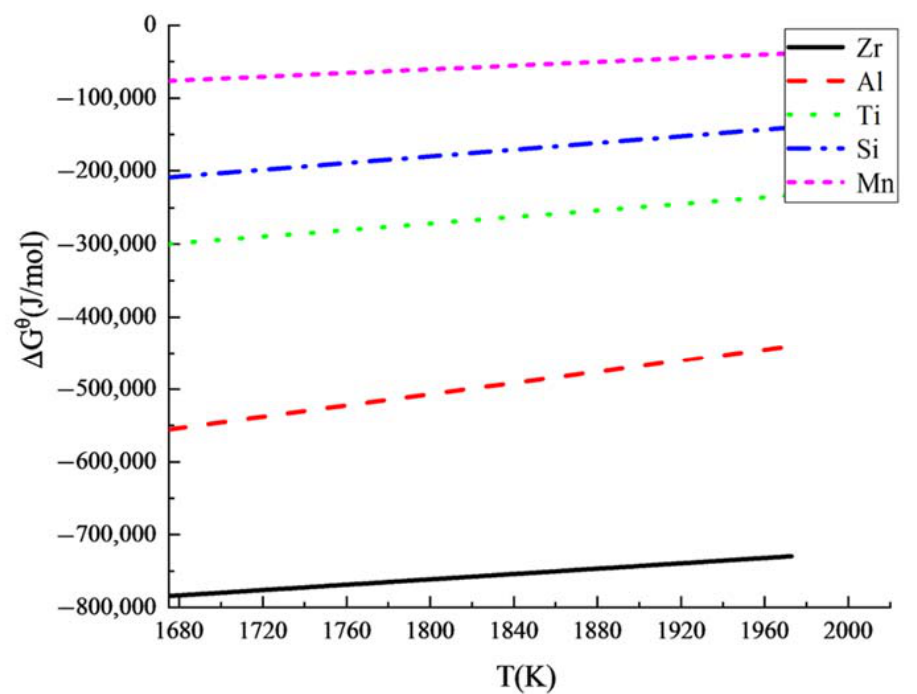
Figure 2. The variation tendency between standard Gibbs free energy and temperature.